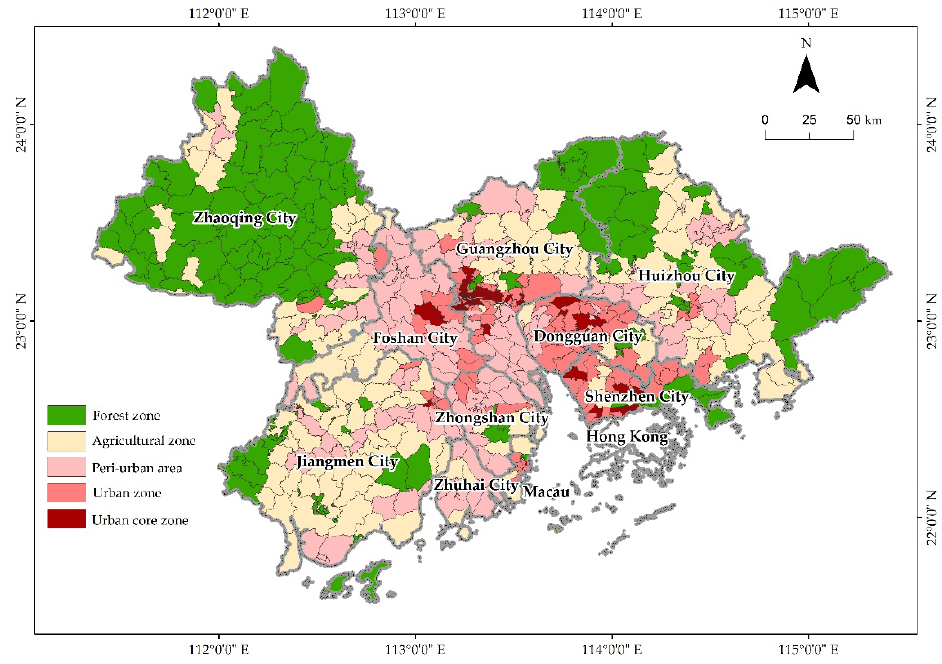
Figure 4. The urban-rural gradient distribution map of the PRD with 665 towns as the units of anal- ysis.